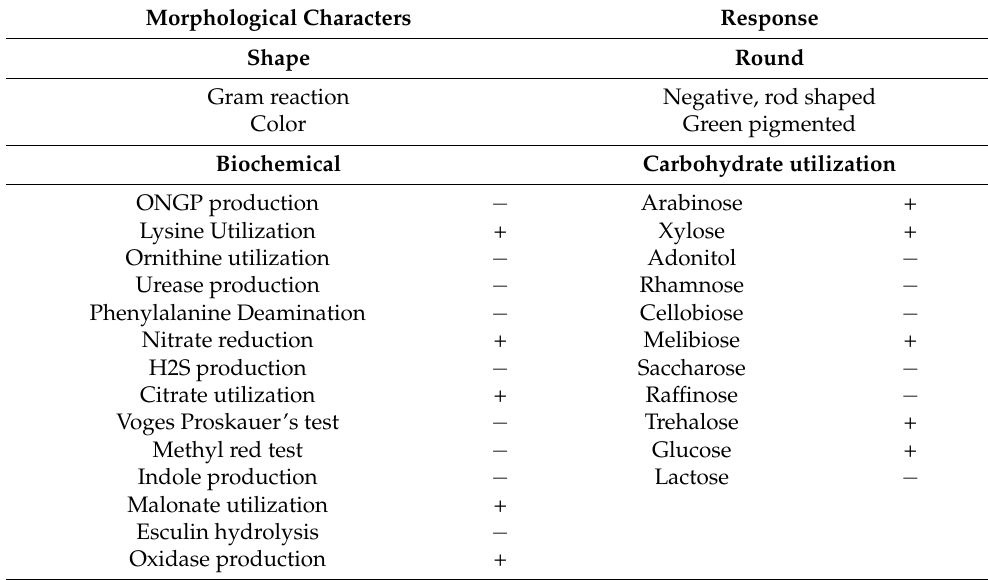
Table 2. Morphological and biochemical characteristics of the strain A7. + Positive, − Negative. Morphological